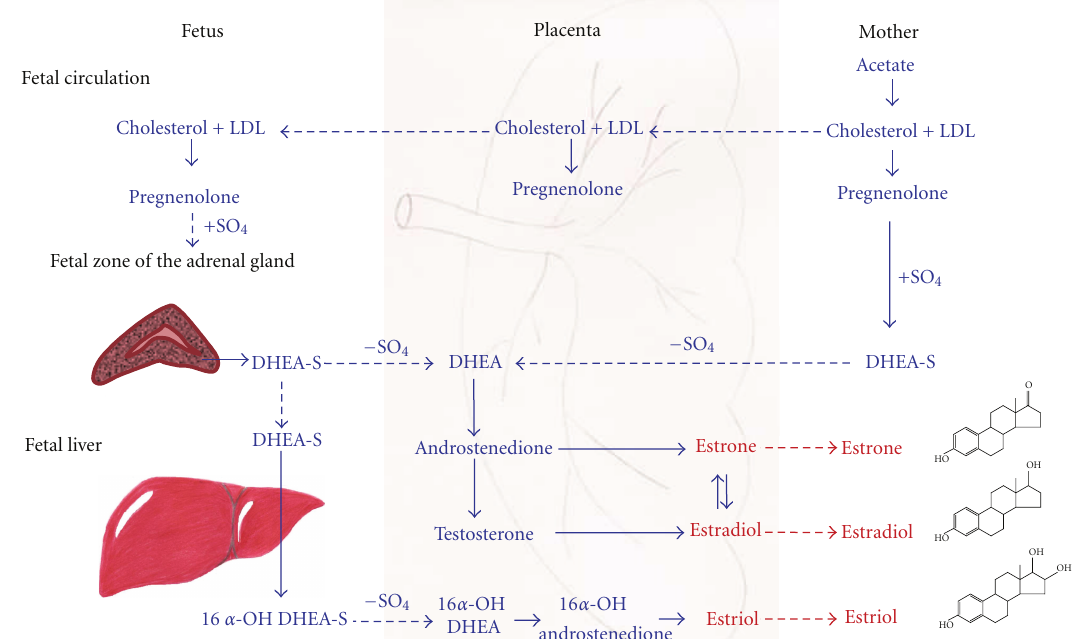
Figure 1: The role of maternal, placental, and fetal units in the biosynthesis of estrone, estradiol, and estriol. (LDL: low-density lipoproteins; DHEA-S: dehydroepiandrosterone sulfate; OH: hydroxyl). This figure has been modified from [8, 14].